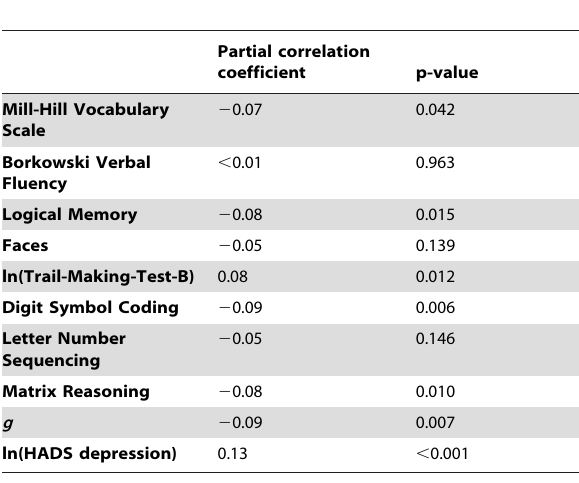
Table 2. Age and sex-adjusted two- tailed partial correlations of NT-proBNP with cognitive and depression scores.